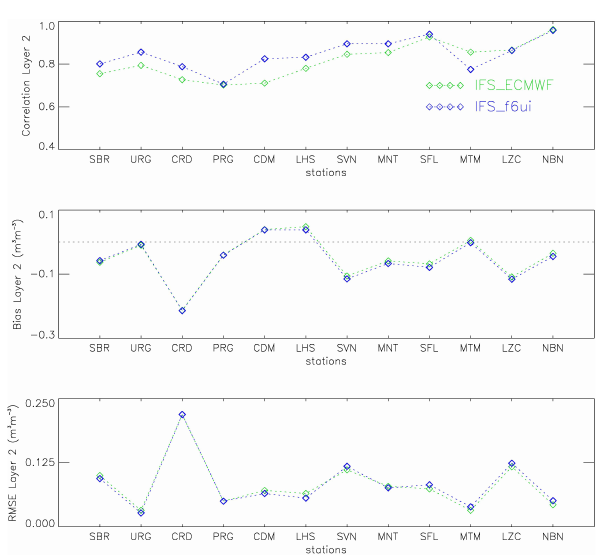
Fig. 9. Evaluation of the ECMWF root-zone (7–28cm) soil mois- ture analysis using the soil moisture observations at 20cm of the twelve stations of the SMOSMANIA network. From top to bottom: correlation, mean bias and